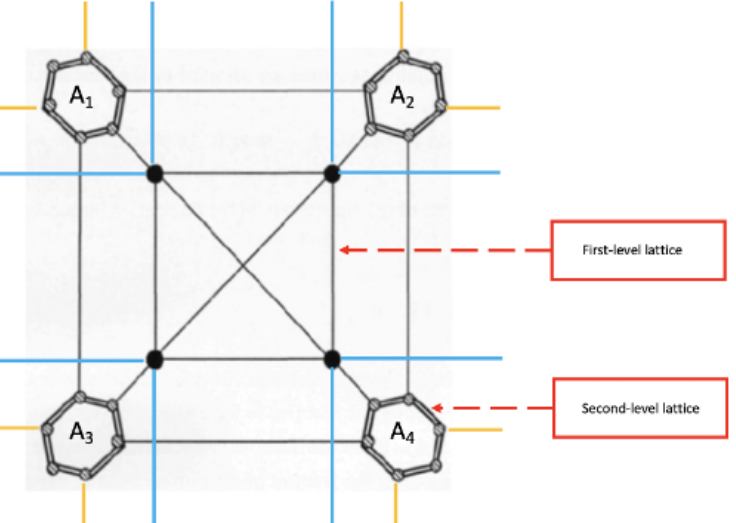
Figure 2. Primitive cell of a complex lattice: the blue lines indicate that the point masses of the square lattice are connected with their analogous in the neighboring primitive cells; the yellow lines indicate that the substructures A i in the second-level lattice are connected with the first-neighbor substructures pertaining to the neighboring primitive